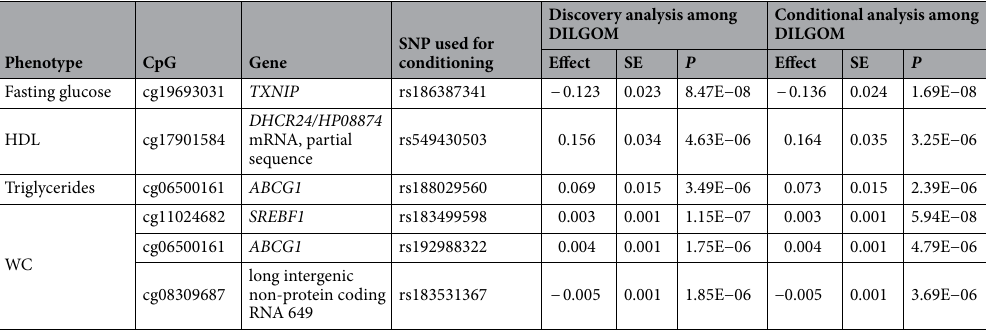
Table 4. Conditional analysis for the replicated CpG M value—phenotype associations. DILGOM dietary, lifestyle, and genetic determinants of obesity and metabolic syndrome, WC waist circumference, CpG cytosine–guanine dinucleotide, SNP single-nucleotide polymorphism, SE standard error.